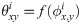
3D mathematical model of individual axon growth.(A) The axon elongates step by step (grey segments), each step being delimited by the current point in space i and the previous one, i − 1. Each ith new step is described by its spherical coordinates (Δρ, ϑ, φ) (represented in 2D for simplicity; see upper left corner for a 3D view), and placed after the previous position i − 1. The exact position of the ith point is defined (in 2D) by θxyi=f(ϕx,yi), which is drawn from a conditional Normal probability distribution (in green). The most probable value (mean of the distribution (μ)) considers the directions of the last step i − 1 and of the attractive field, each contribution weighted by α and β respectively. For each time unit tj, a maximum number of steps (nmax) is allowed. (B) Algorithmic implementation of branch generation. During tj, a certain number of growth steps are performed (3 in this schematic representation). At the end of tj, a certain “condition” is evaluated and, if true, a branch point is placed at the axon tip, or at any other step performed during tj (step 2). (C) Step by step axon growth scheme during tj considering physical interactions. The axon elongates of n steps (I), until it encounters a mechanical constraint (II) and retracts (III). During the same time interval tj, it will re-try to reach nmax steps (6 in this example). If no other mechanical constraint is encountered (CASE A), the axon will advance to reach nmax steps. If, on the contrary, another mechanical constraint is encountered (CASE B), the axon will retract again and stop its growth until the next time point (tj+1). In this case, the total growth during tj is then smaller than nmax steps.